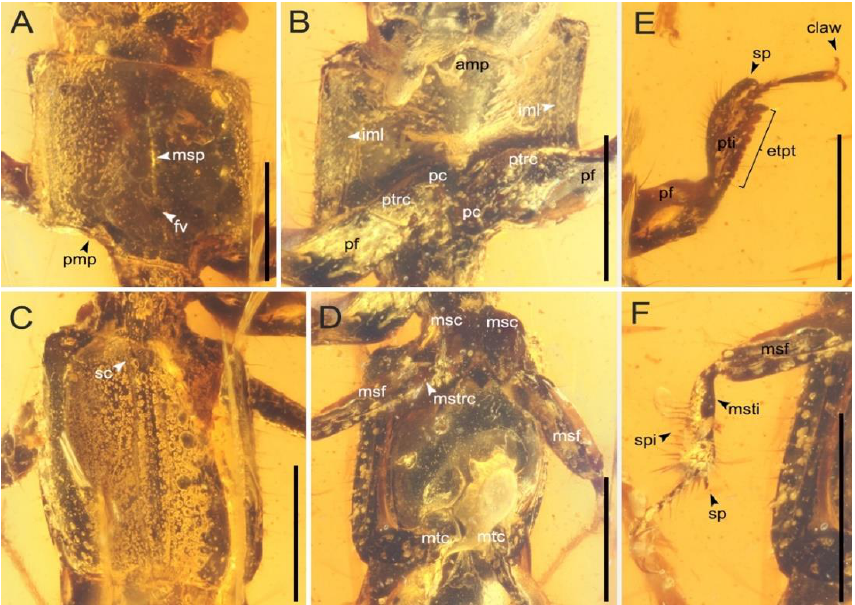
Figure 3. Thorax and legs of Priochirus trisclerite sp. nov., holotype, QUST-SHUO-0003. ( A ) Pronotum, dorsal view. ( B ) Pronotum in ventral view. ( C ) Mesoscutellum and elytra, dorsal view. ( D ) Meso-